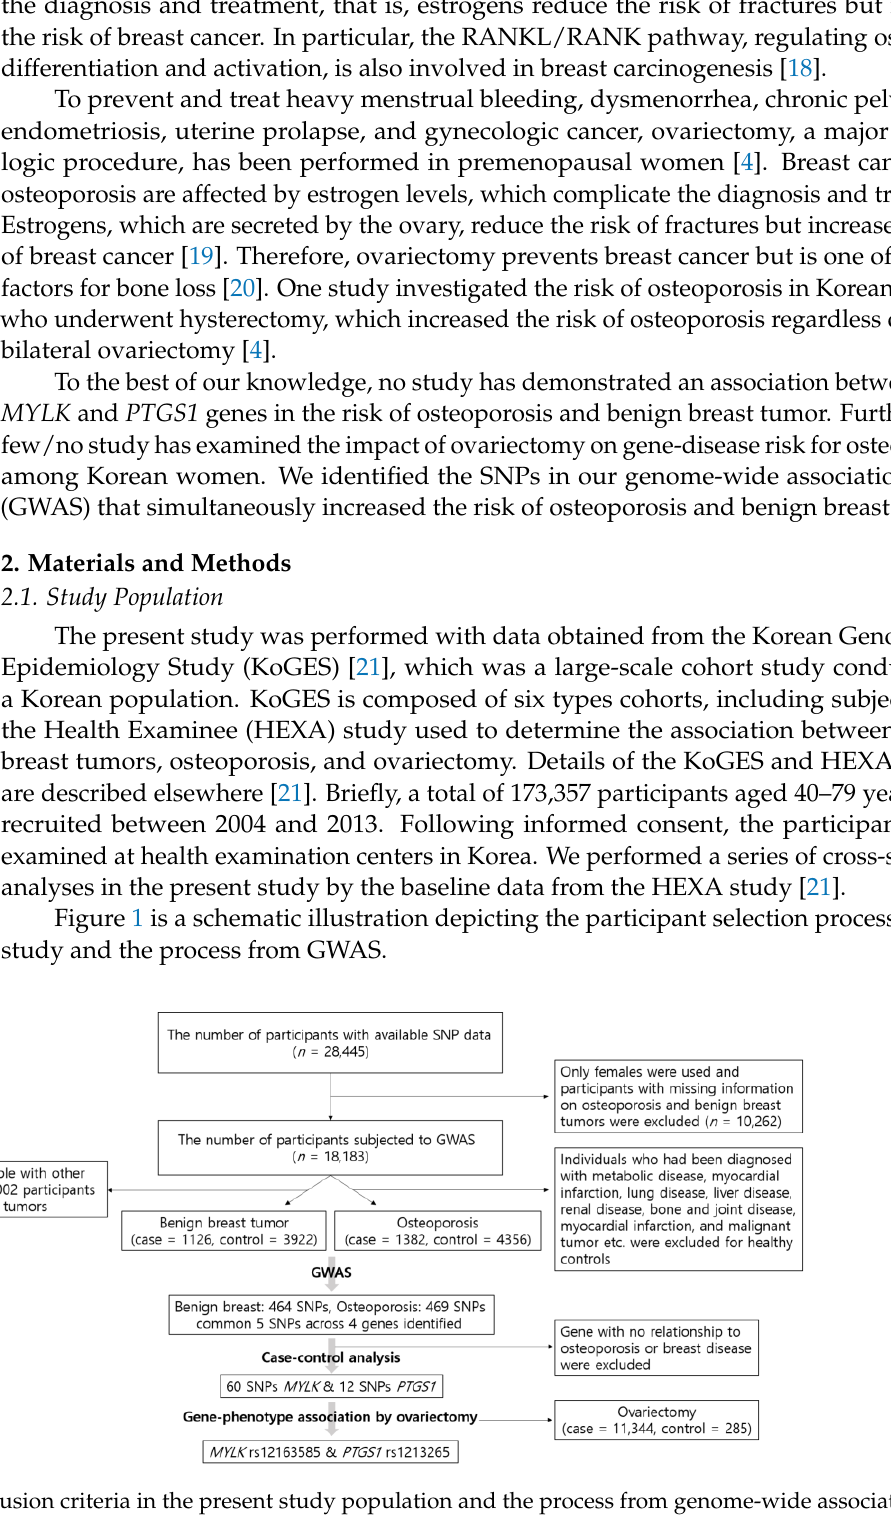
Figure 1. Flow chart of exclusion criteria in the present study population and the process from genome-wide association study